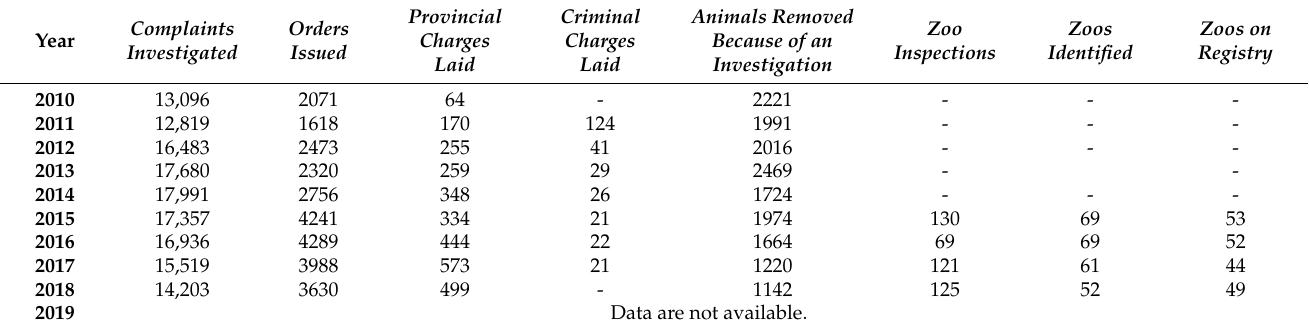
Table 4. Statistical Data from Ontario. Information compiled from OSPCA Annual